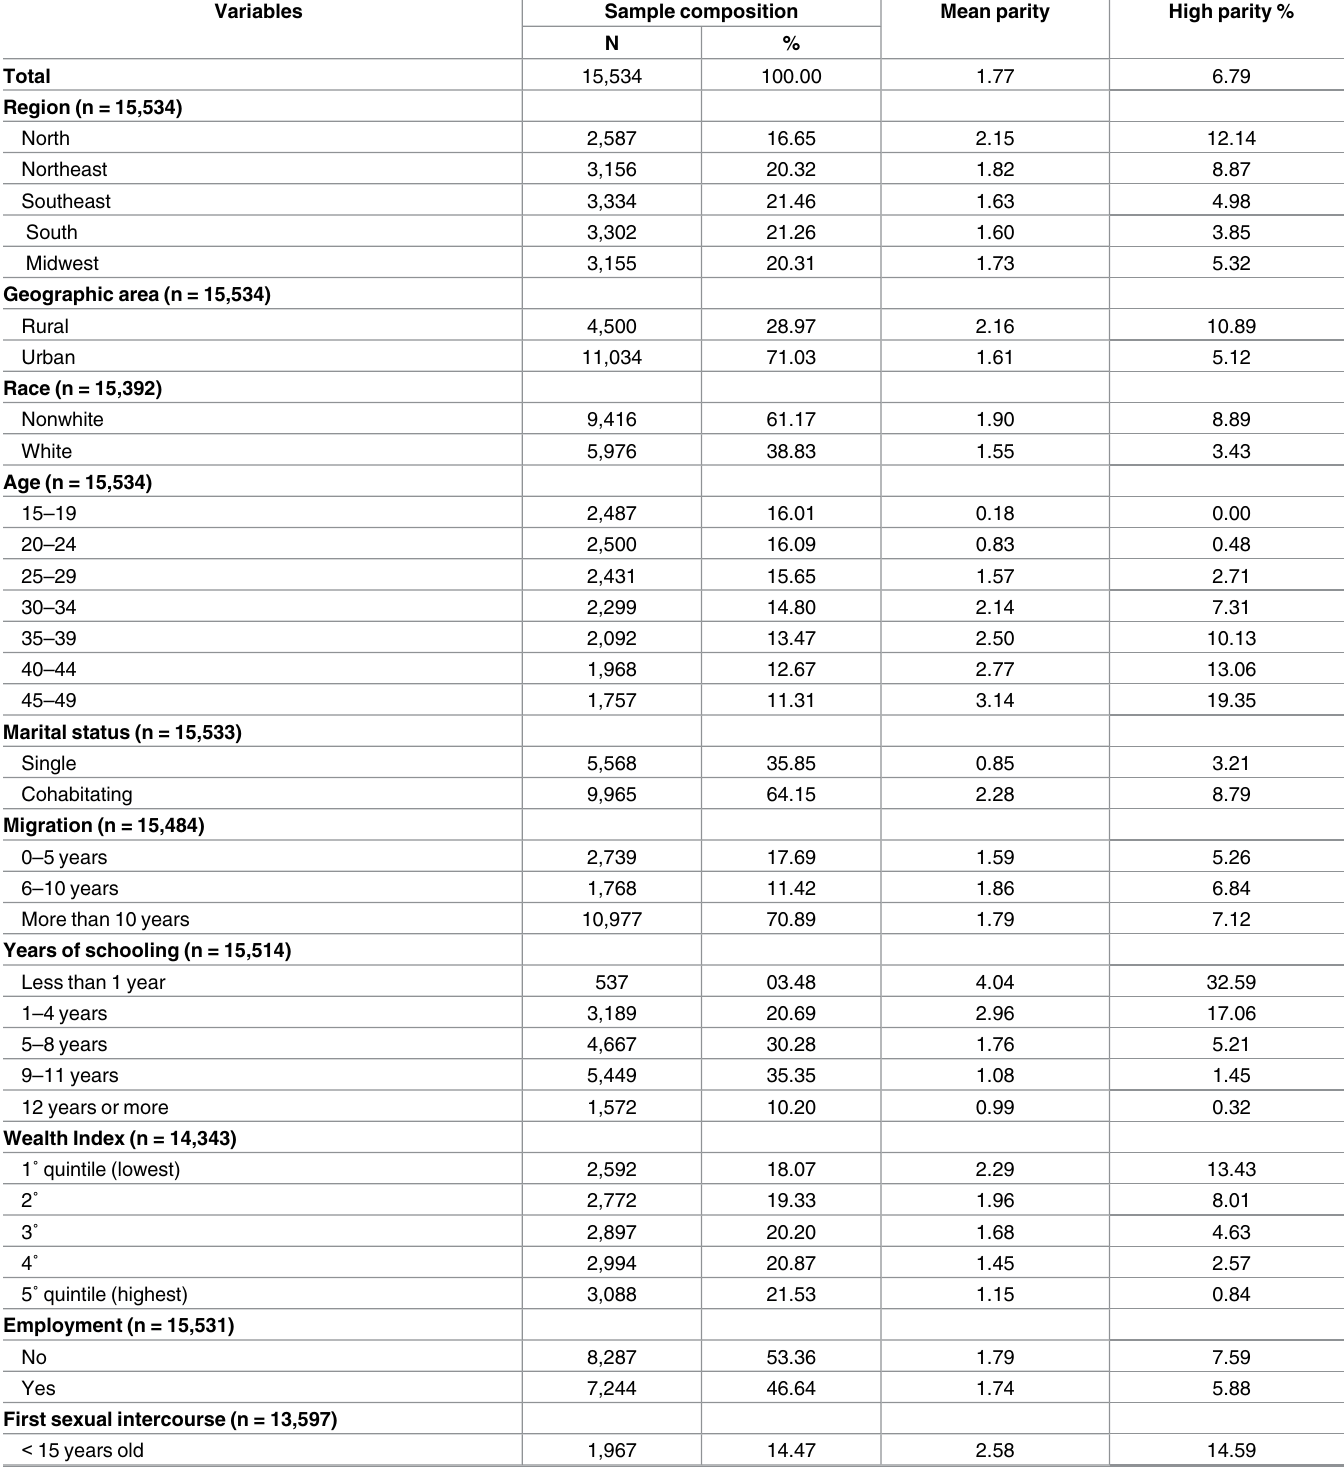
Table 1. Sample description and averagefertility rate according to geographic, demographic, socioeconomic, reproductive, behavioral, and health